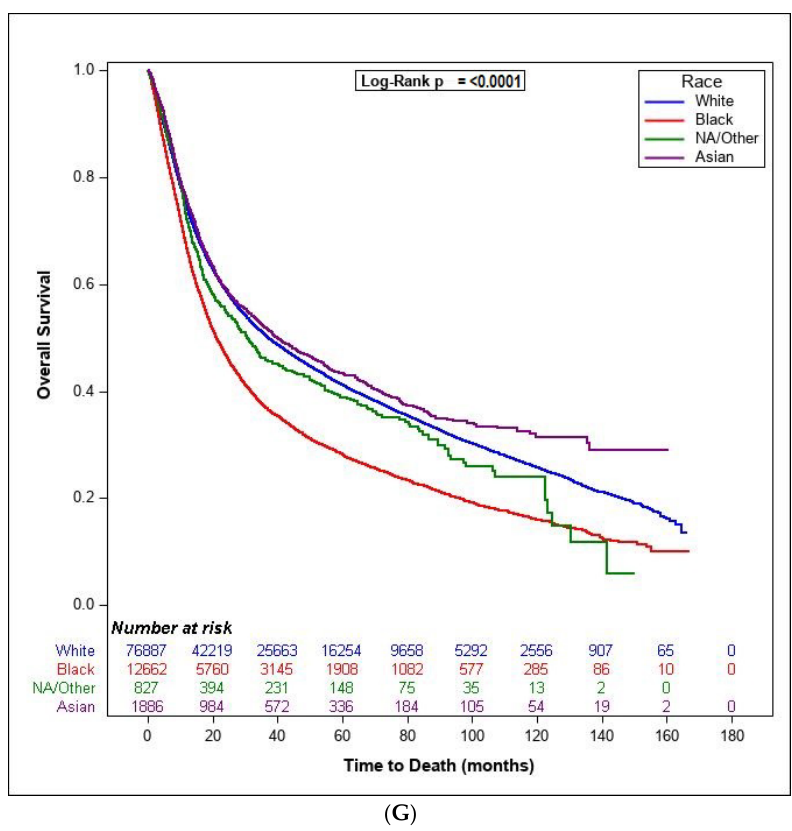
Figure 2. Overall Survival by Racial/Ethnic Minority for ( A ) the entire cohort; ( B ) White vs. non - White; ( C ) Hispanic Black vs. non - Hispanic Black; ( D ) Stage I; ( E ) Stage II; ( F ) Stage III; ( G ) Stage IV.